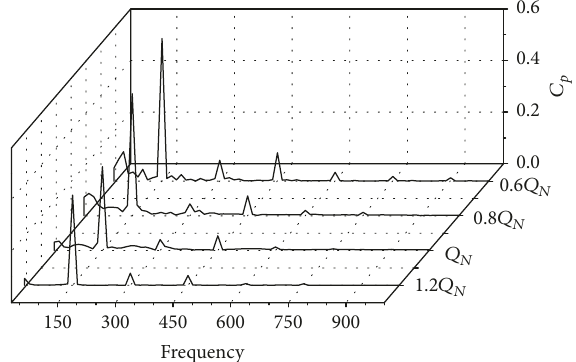
Figure 13: Frequency domain comparison of Q2 under multiple